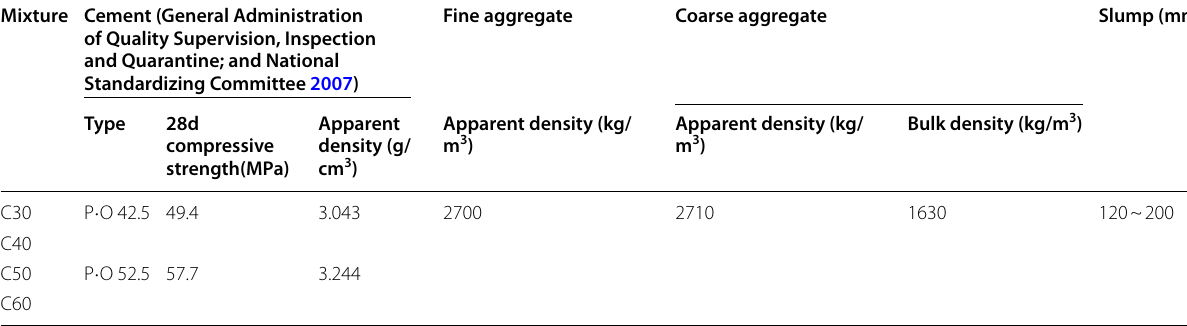
Table 1 The physical properties of materials used in configuring concrete Mixture Cement (General Administration of Quality Supervision, Inspection and Quarantine; and National Standardizing Committee